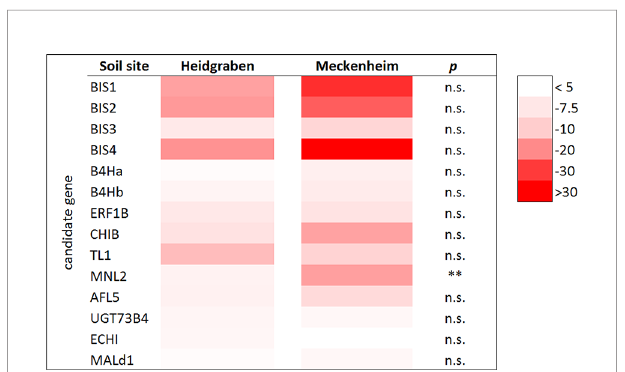
FIGURE 4 | Regulation of CG expression in roots of plants grown in the ARD soils Heidgraben and Meckenheim including mean gene expression data of the genotypes B63, M26, and MAL0595, with fi ve replicates for each genotype. The heat map indicates the fold change values (ARD soil/ g ARD soil) with the rows displaying the selected 14 CGs with an average signi fi cant fold change value > 4.5 in root tissue. The columns display the soil sites Heidgraben and Meckenheim. The intensity of the red color corresponds with the detected fold change value. p < 0.01 (**) and n.s., not signi fi